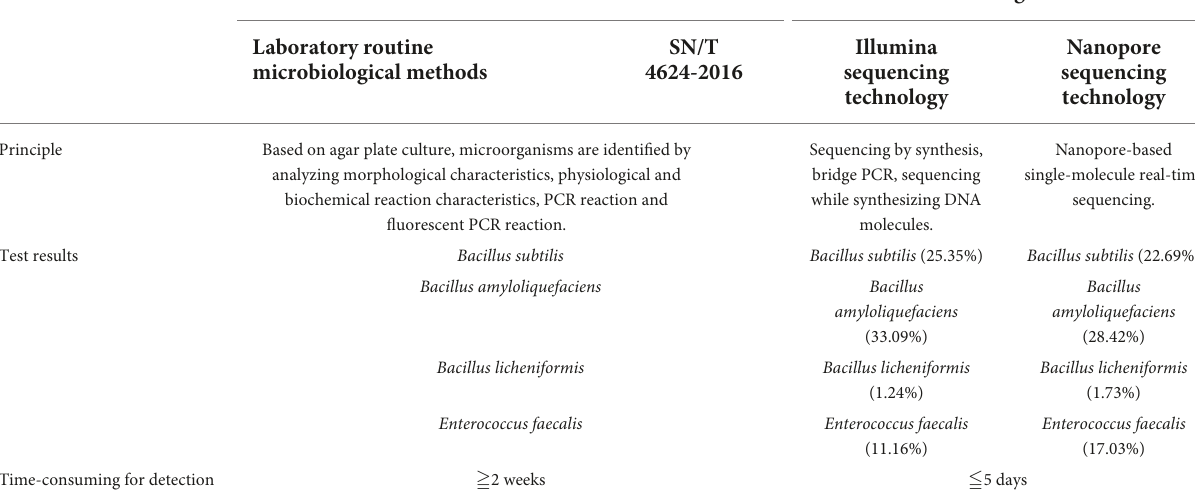
TABLE 2 Comparison of traditional methods and sequencing methods for imported microbial inoculants.